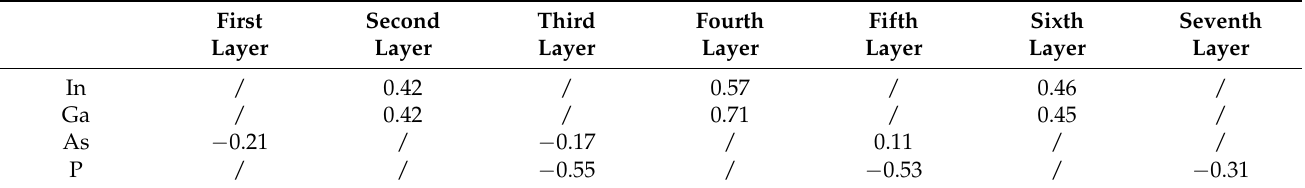
Table 2. Mean Mulliken charge distribution in each layer of In 0.87 Ga 0.13 As 0.25 P 0.75 (001) β 2 (2 × 4)